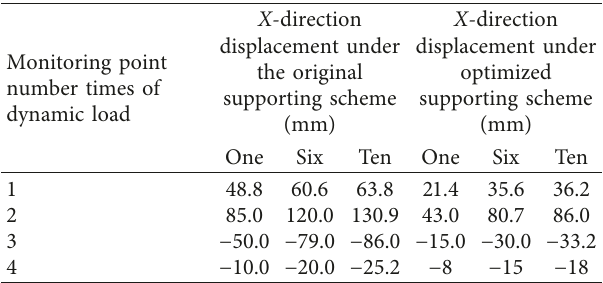
Table 3: X -direction displacements for one, six, and ten dynamic loads.